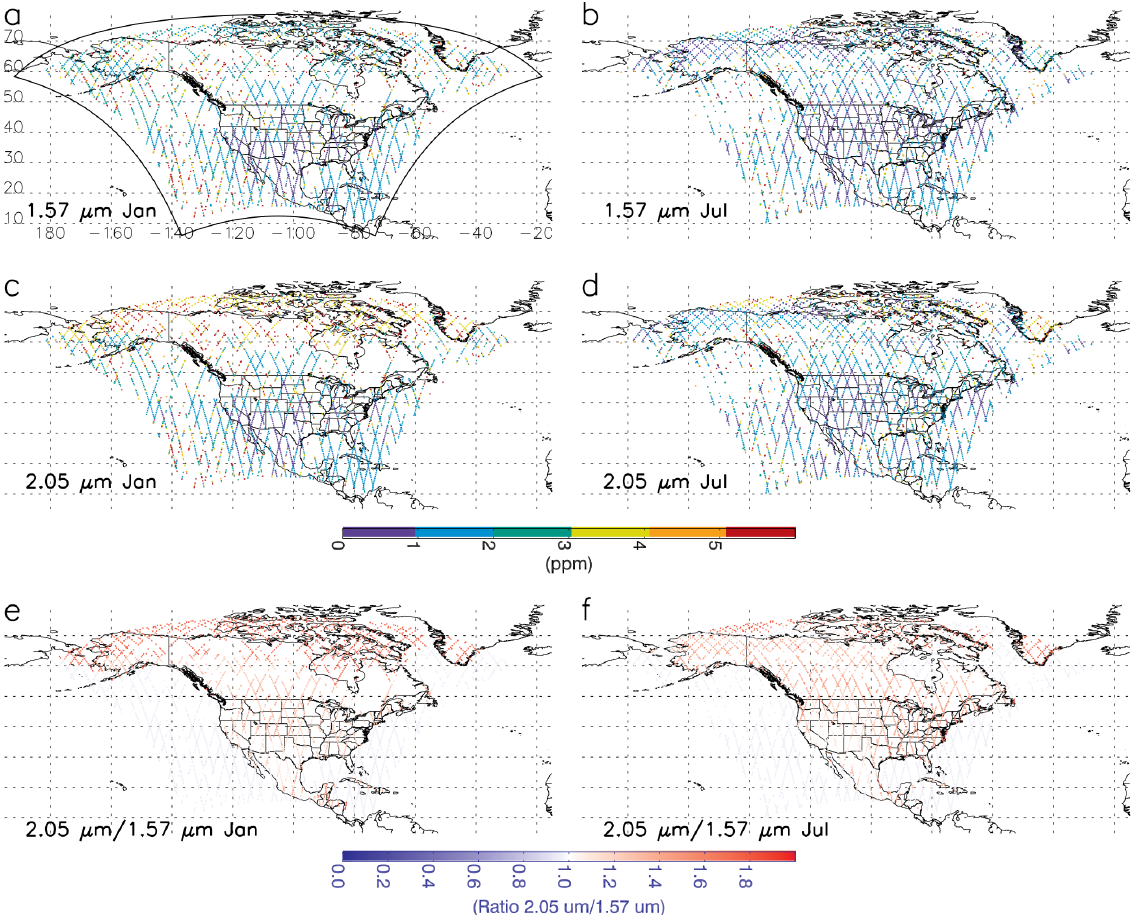
Figure 2. Examples of measurement locations (individual 10sec averages) and 10sec uncertainties (1 σ) for the 0.5ppm RRV random error case across 7-day spans for (a) the 1.57µm wavelength in January and (b) in July; for (c) the 2.05µm wavelength in January and d) in July. Locations with OD >0.7 are rejected. The uncertainty ratio of the 2.05µm to 1.57µm wavelength (e) in January and (f) in July. The WRF domain for the runs utilized in this study is indicated by the bold black lines in (a)